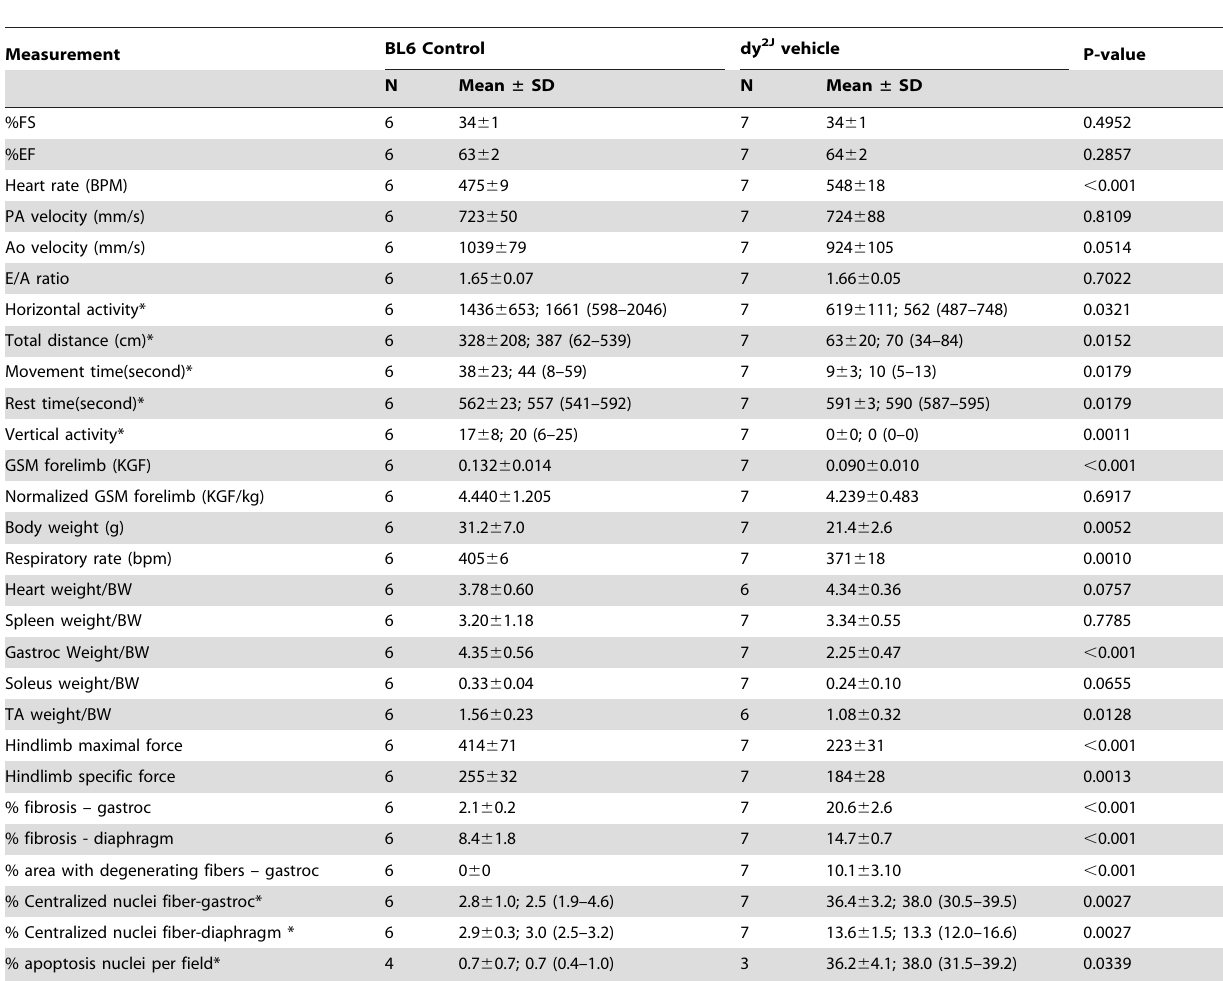
Table 2. Outcome measures for BL6 control and vehicle treated dy 2J mice at 30–33 weeks of age show decreased activity, in vitro force and